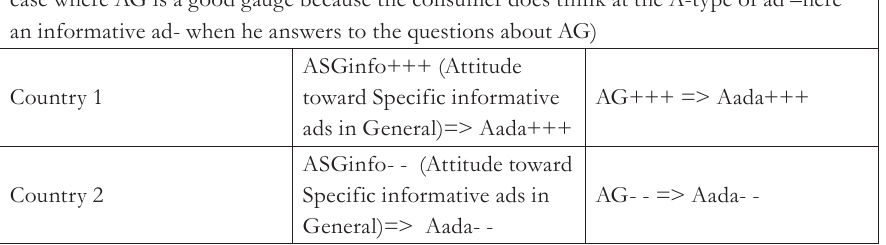
Tab. 1 - Example of two different relationships between AG and Aad. Source: authors Campaign A (with an informative